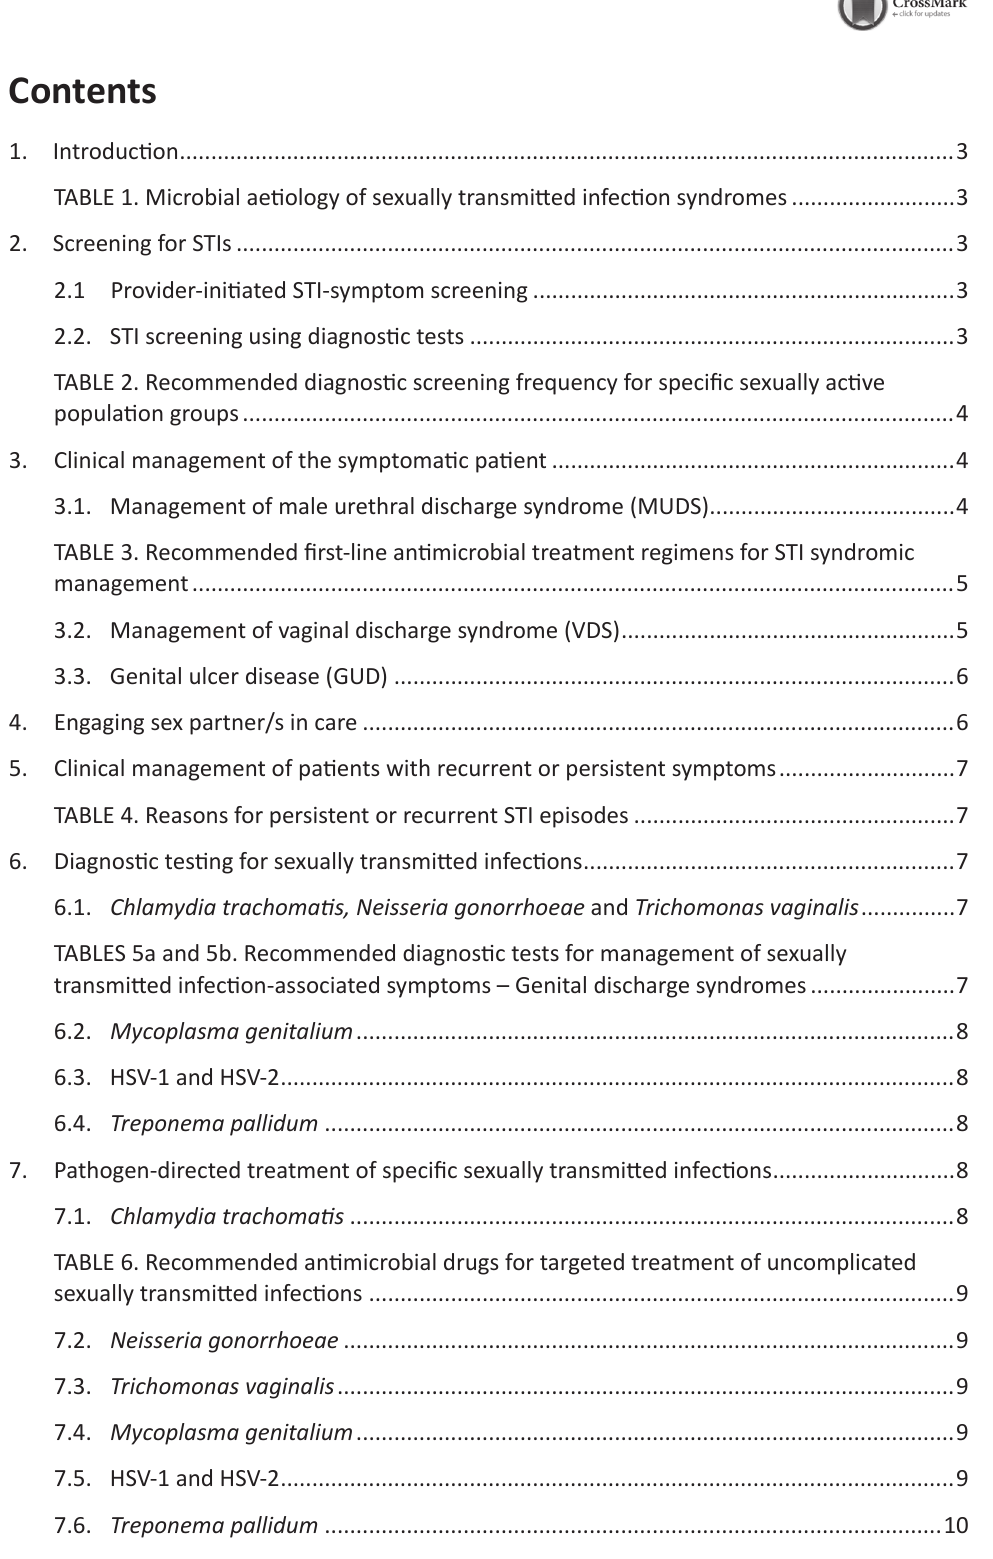
TABLE 6. Recommended antimicrobial drugs for targeted treatment of